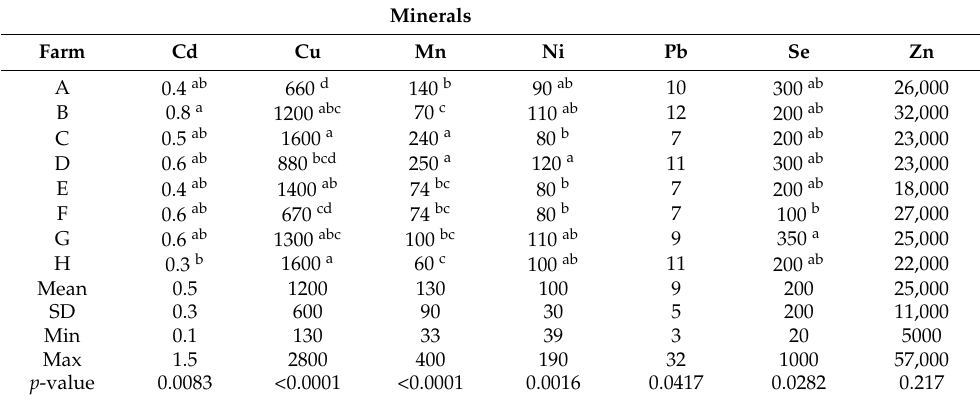
Table 2. Concentration ( µ g kg − 1 ) of essential and toxic minerals in colostrum sampled in eight farms. Minerals